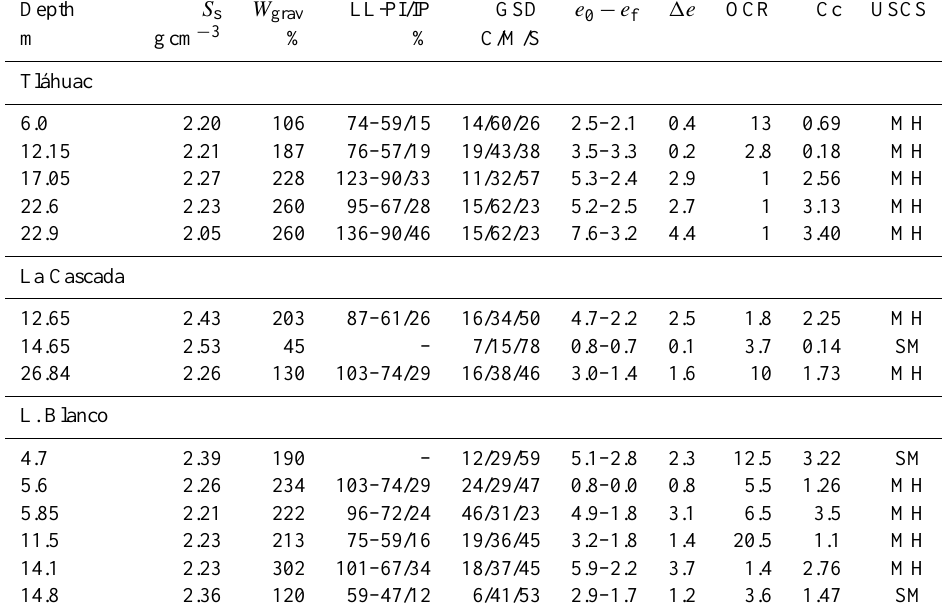
Table 1. Physical and mechanical characterization of the studied lacustrine sequences. S s , solid density; W grav , gravimetric water content; GSD, Grain Size Distribution: C, Clay, M, Silt, S, Sand; e 0 and e f , initial and final void ratio, OCR, Overconsolidation Ratio, Cc, Compress- ibility Index, USCS, Unified Soil Classification System: MH, High Plasticity Silt, SM, Silty